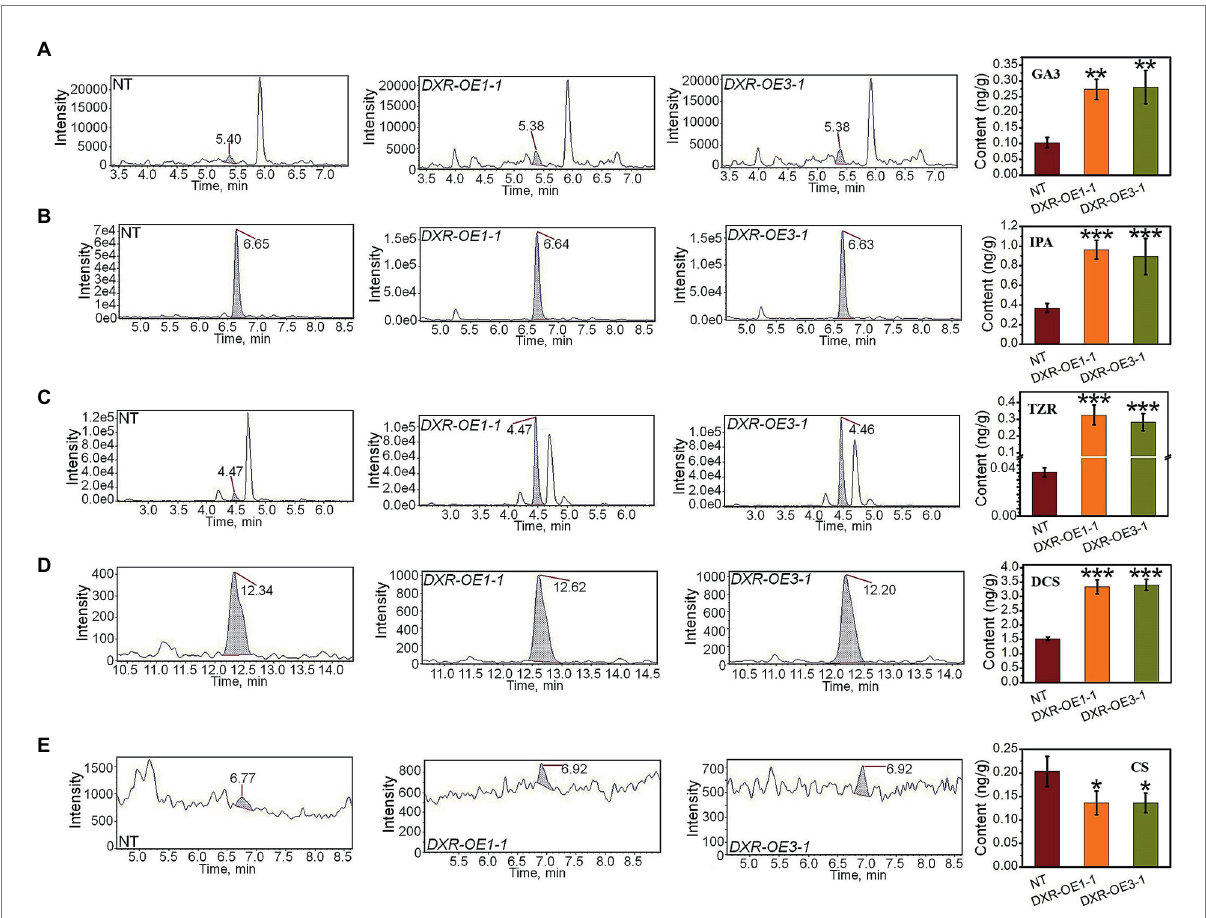
FIGURE 5 Analyzing the effect of the overexpression of PtDXR on MVA and MEP-derivatives. HPLC-MS/MS analyses of the contents of GA 3 (A) , IPA (B) , TZR (C) , DCS (D) , and CS (E) in PtDXR - OEs compared to NT